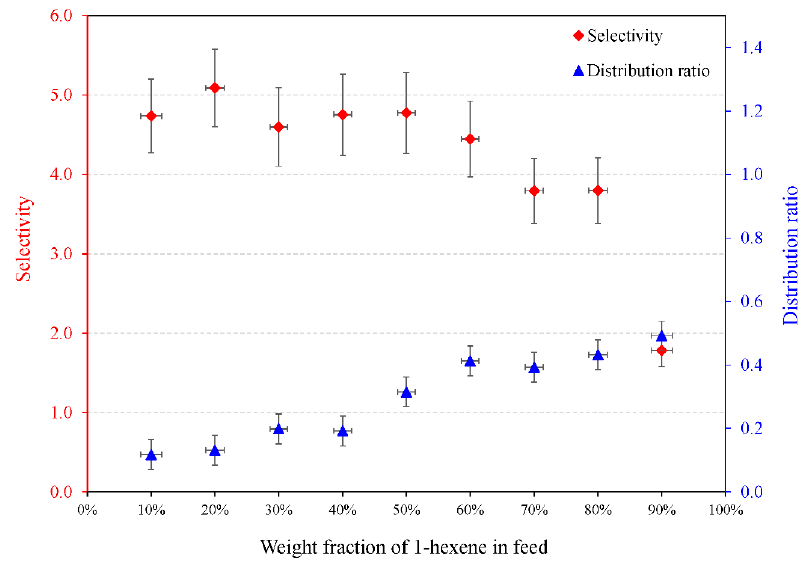
Separations 2022 , 9 , x FOR PEER REVIEW 13 of 19 Figure 6. Variation of the selectivity and the distribution ratio with toluene weight fraction in the feed for {1-hexene (1) + toluene (2) + DES #2 (3)}.